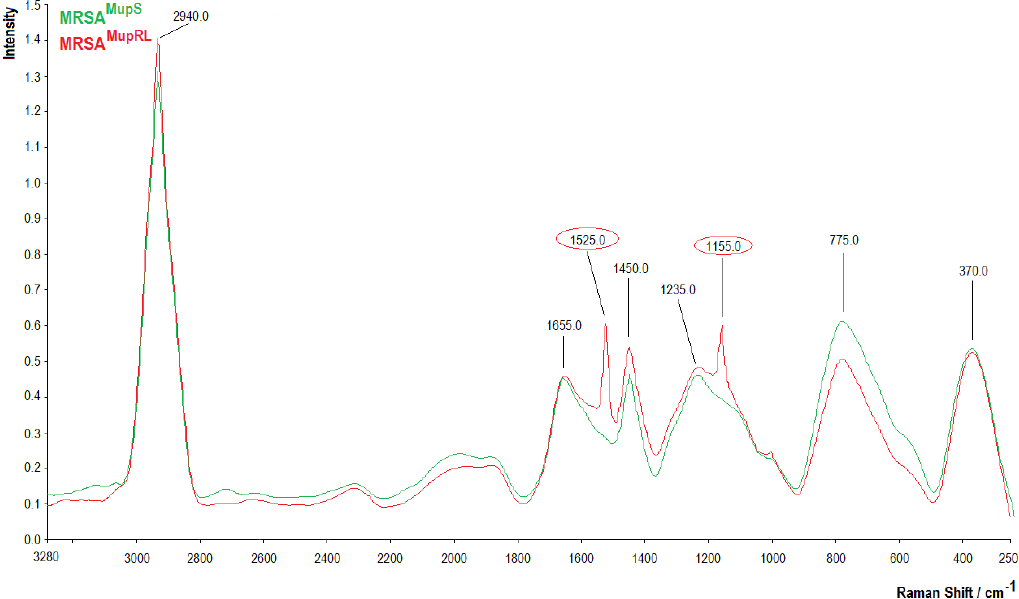
Figure 3. Raman spectra of MRSA MupS and MRSA MupRL strains.